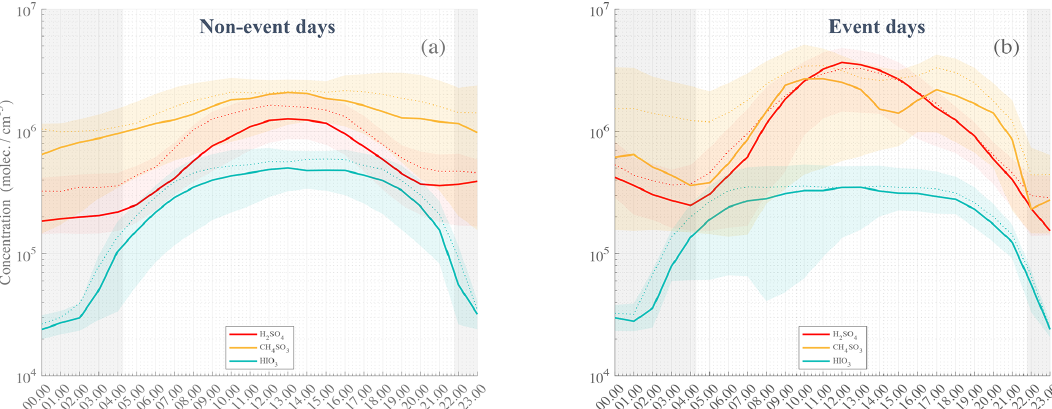
Figure 5. Statistical diurnal time series of H 2 SO 4 (SA, red), CH 4 SO 3 (MSA, orange), and HIO 3 (IA, green) observed during non-event days (a) and event days (b) . The solid lines represent the median hourly average concentrations; the dotted lines are the concentration means; the colored shaded areas show data points within the 25th and the 75th percentiles. Nighttime is represented by the gray-shaded area with median theoretical sunsets and sunrises occurring during the campaign. The actual sunset and sunrise values could vary by approx. ± 1 . 25h from the beginning to the end of the